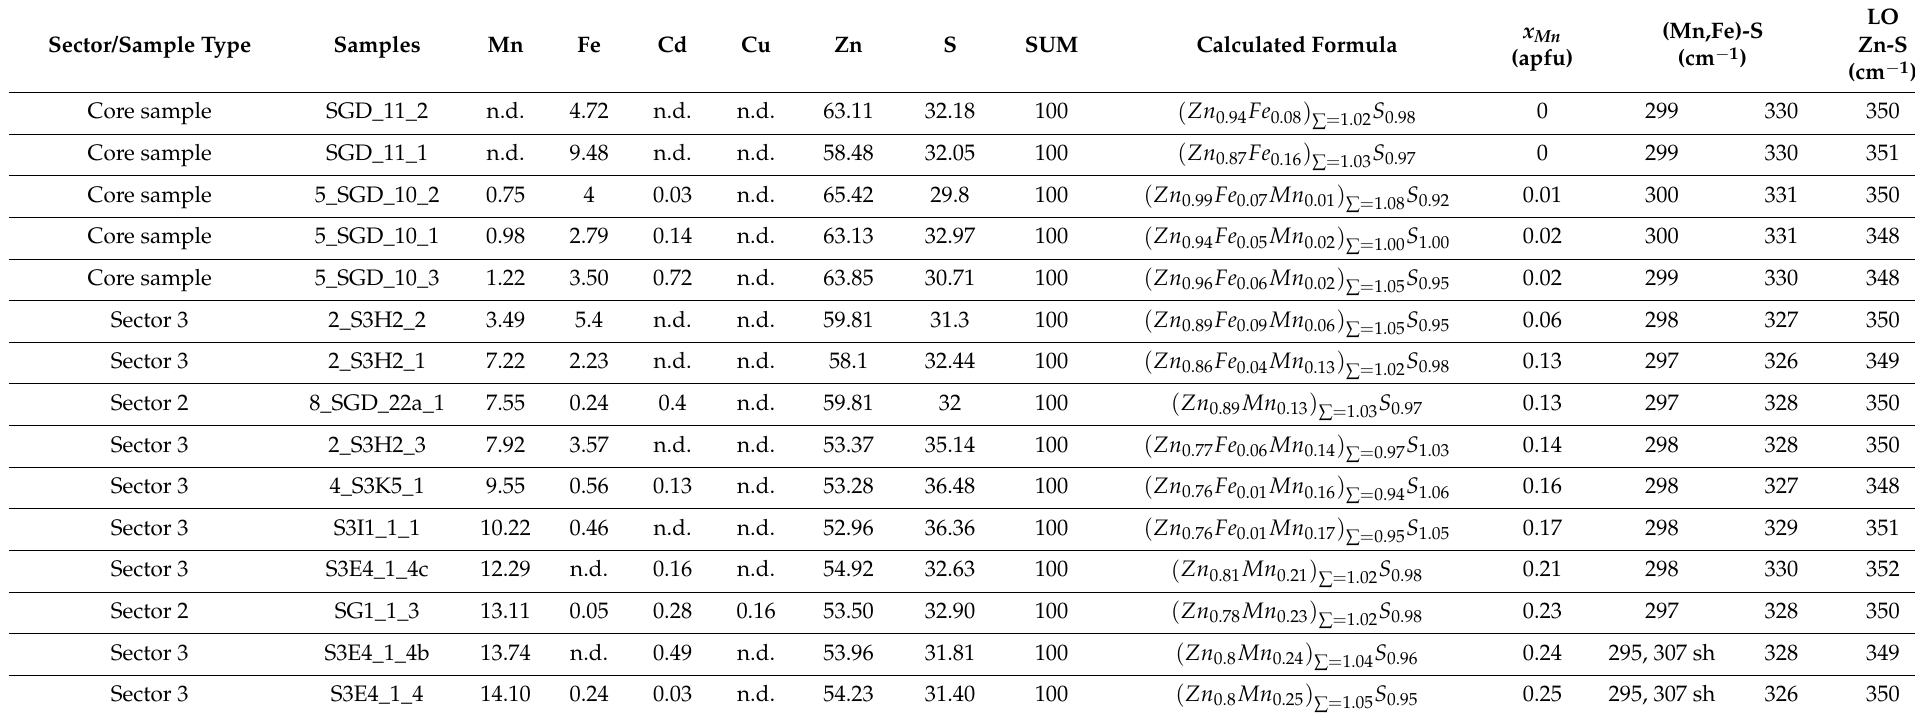
Table 1. Chemical composition of sphalerite samples (wt.%) ordered by Mn content and the main Raman